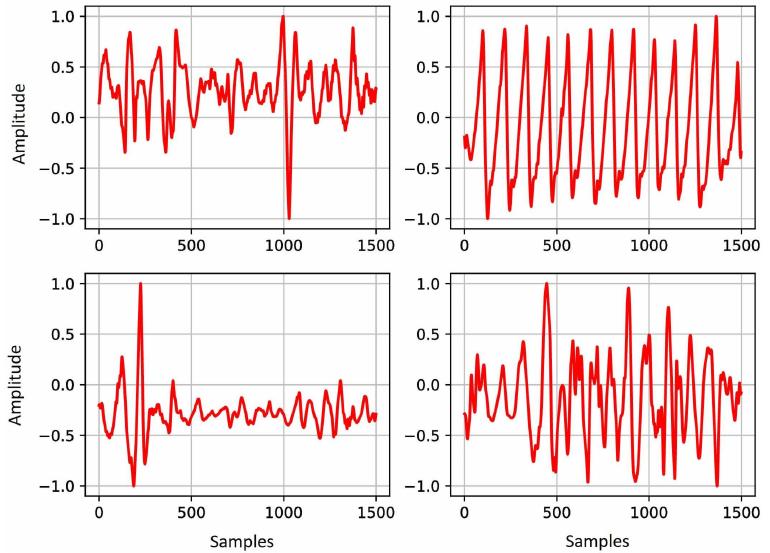
Figure 12. Examples of PPG data with different noise levels used in the training phase. The upper right figure illustrates a low-noise PPG signal, while the other examples contain different types of noises, such as motion artifact and baseline wander. The x -axis is the samples and the y -axis is the